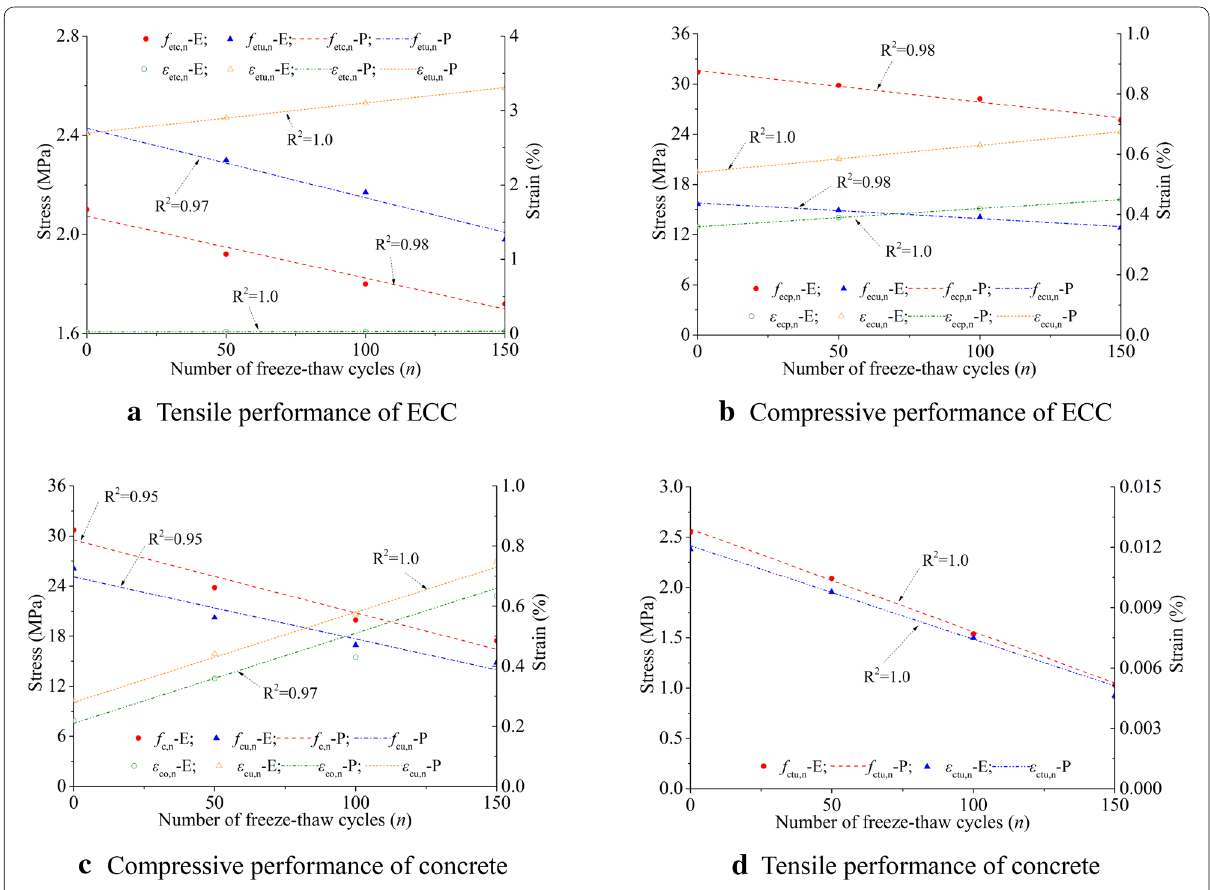
Fig. 11 Comparison of experimental and predicted critical values required by constitutive models of ECC and concrete.